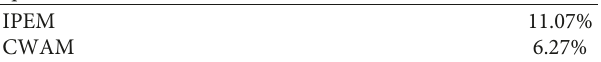
Table 4: The third point’s excitation relative errors of root mean square